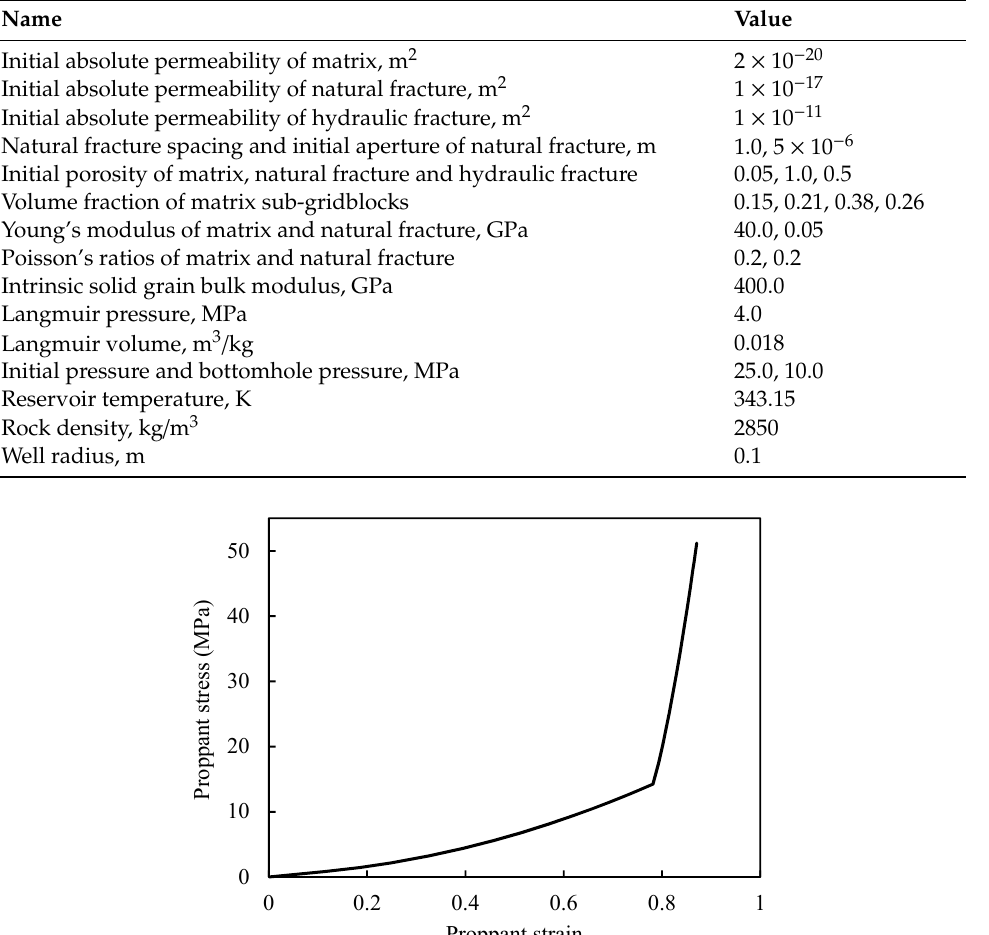
Table 2. Parameters of the shale reservoir for applications and discussions.